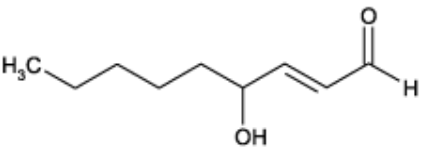
Figure 3. Chemical structure of 4-hydroxy-2- trans -nonenal